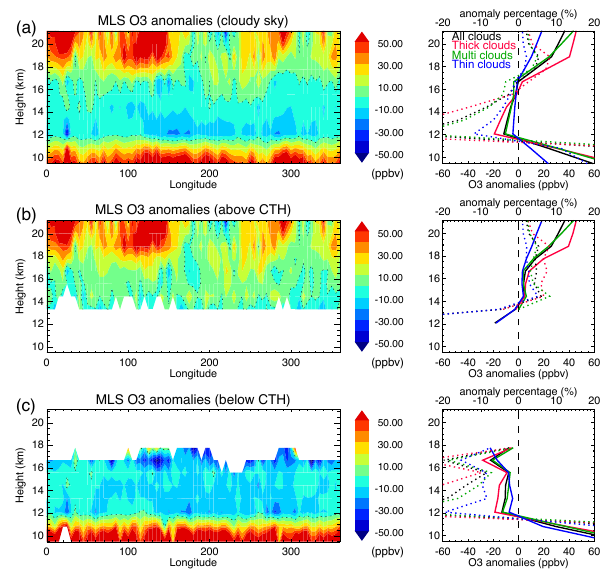
Fig. 8. The same as figure 4 except ozone anomalies.